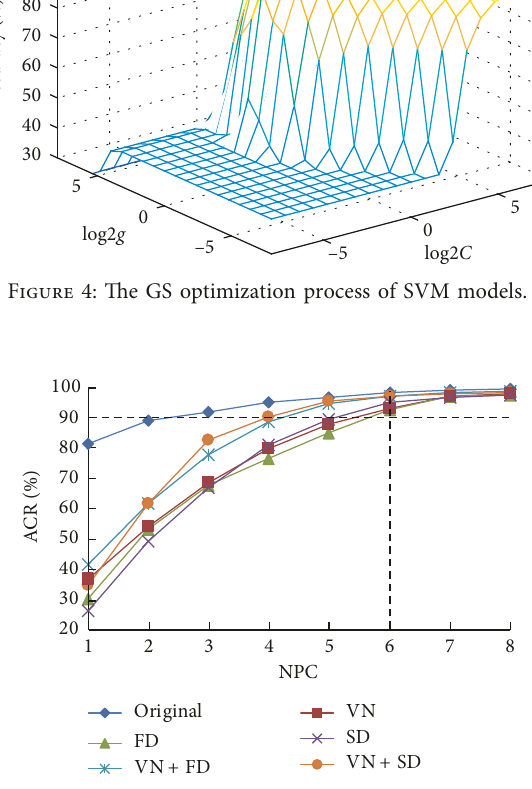
Figure 5: ACR of PCs of original spectra and pretreated